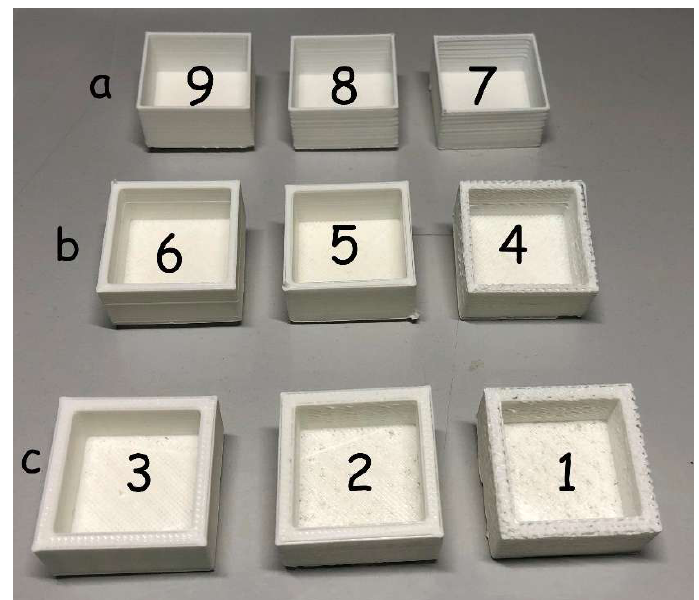
Figure 2. The nine printed items. From left to right: ( a ) First row (1 mm wall): Models 9 (230 °C), 8 (220 °C), and 7 (210 °C), ( b ) Second row (2 mm wall): Models 6 (230 °C), 5 (220 °C), and 4 (210 °C), ( c ) Third row (3 mm wall): Models 3 (230 °C), 2 (220 °C), and 1 (210 °C).